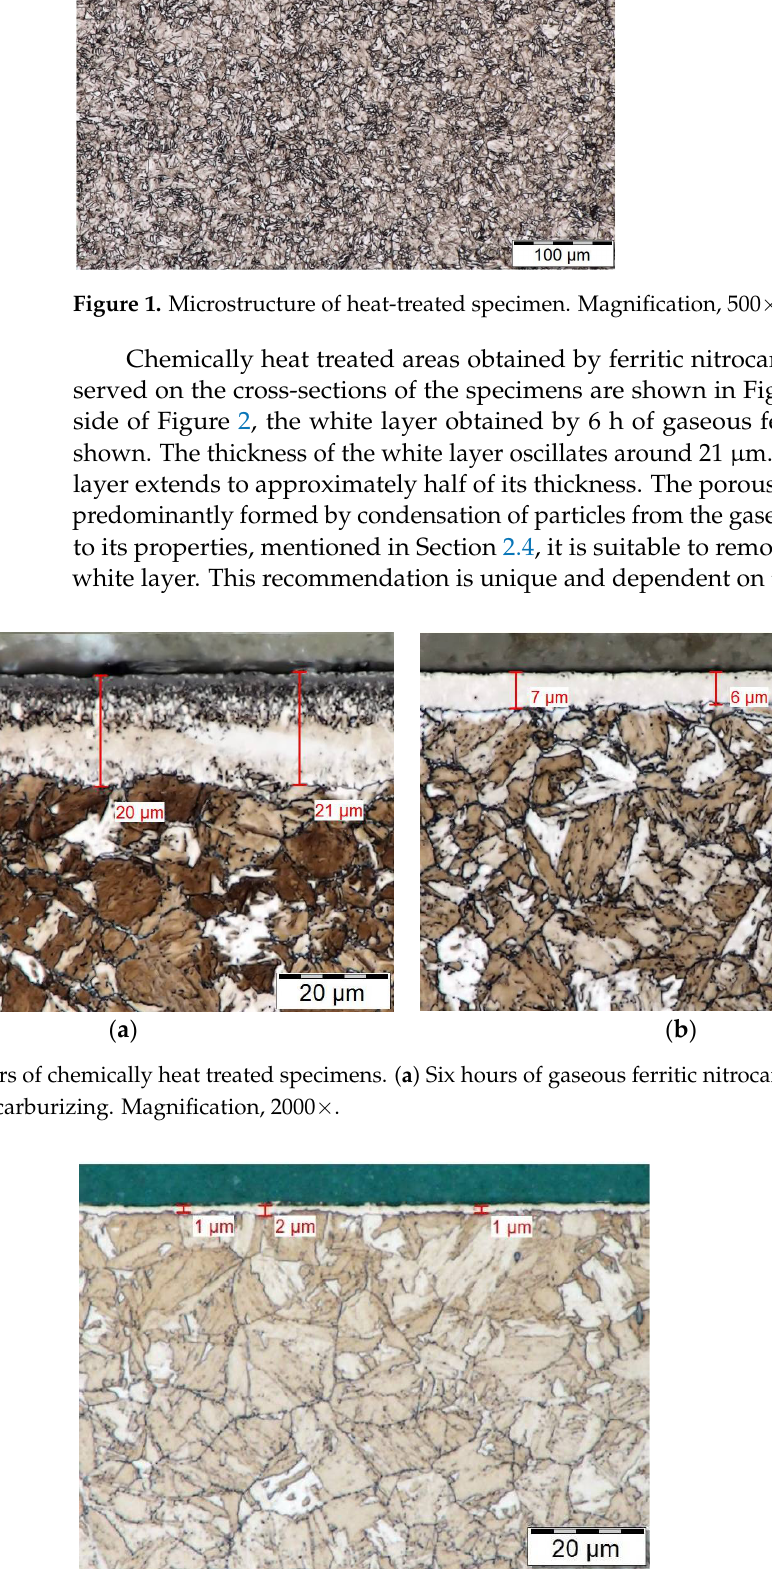
Figure 3. White layer after 4 h of gaseous ferritic nitrocarburizing. Magnification, 2000×. The white layer of the specimen after plasma ferritic nitrocarburizing is shown on the right side of Figure 2. The white layer obtained by plasma ferritic nitrocarburizing is about three times thinner and almost pore-less in comparison with the previous case. Although properties of the white layer obtained after 6 h are better in this case, the paper aims to achieve a white layer-less surface to reduce the possible need of subsequent machining. Therefore, the process of plasma ferritic nitrocarburizing, applied subsequently to the fourth specimen, was shortened to a period of 4 h. An obtained white layer of this nature is visible in Figure 3. As is shown in the Figure 3, by reducing the process duration a significant narrowing of the white-layer thickness was achieved. Thus, subsequent machining of the surface is no longer necessary. The statements of the previous paragraphs are further supported by pictures of the surface’s morphology shown in Figure 4, obtained by a TESCAN MIRA 4th generation scanning electron microscope with a magnification of 10,000×. ( a )